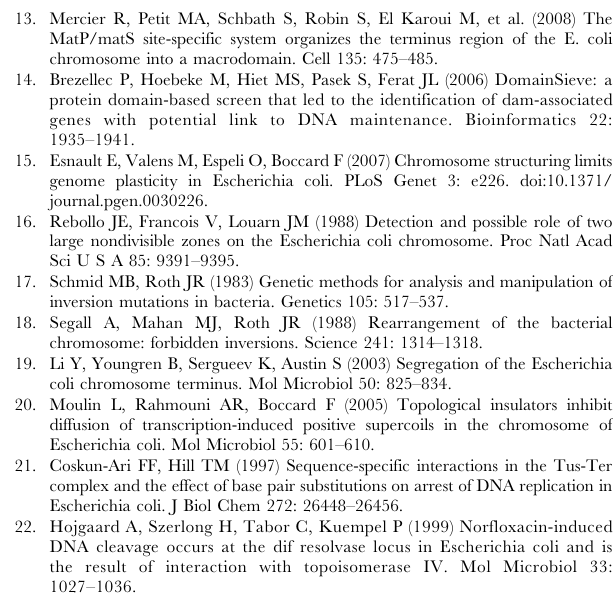
Figure S3 Cells and nucleoid distribution in strain D tidR . (A) Cells were grown until OD 0.2 in LB, fixed and DNA stained with DAPI as described before (Esnault et al., 2007). Percentage of cells in each size category according to their number of nucleoids in the wild type strain (left) and the D tidR strain (right). Green indicates cells containing one and two nucleoids; yellow: cells containing four nucleoids; cyan: cells containing par -like nucleoids; red: cells with unsegregated nucleoid. Figure S4 Alignment of the 34 tidRL -like sequences in the E. coli chromosome. They differ from tidR by one change at a single position. « + » indicates an insulation effect; « 2 » indicates no insulation effect; « ? » indicates that the insulation effect is not determined or can not be predicted. Table S1 Coefficient diffusion of chromosomal markers. Table S2 parS tags used in this study. Table S3 Long range interactions measured by excisive